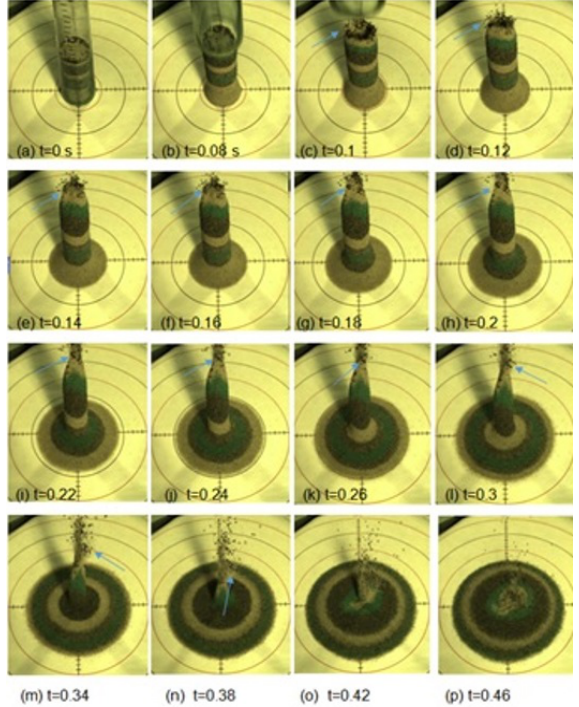
Figure 2. Snapshots of the collapse of a beach sand conical column. Initially, the granular material evolves on the horizontal surface axi-symmetrically (colored layers) but at the end there are ellipse-like deformations at the top. Mustard seeds were added to the top of the column to make its spin more evident.